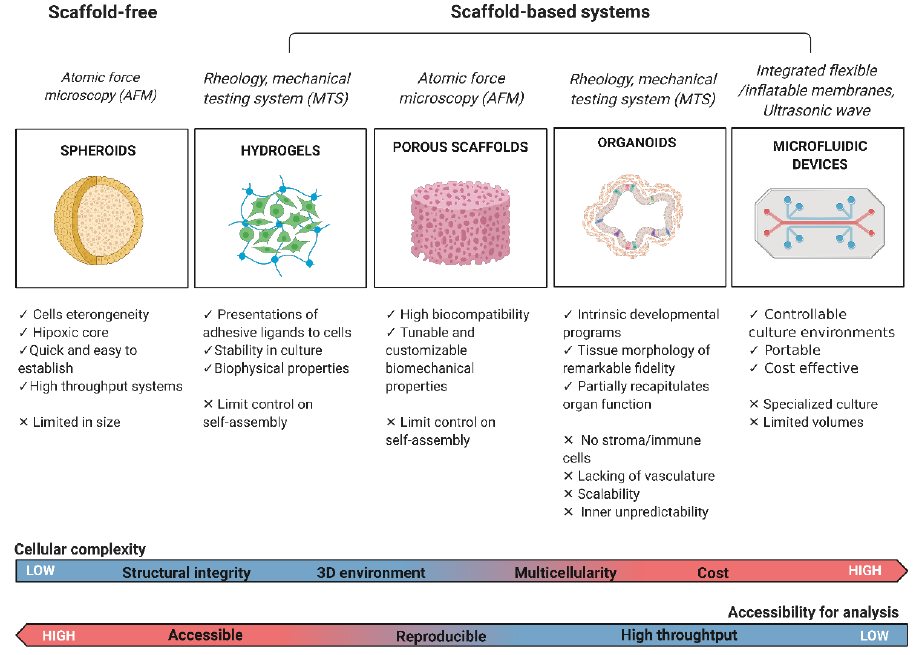
Figure 2. Classification of the most common cancer study models with their strengths and limitations. The primary mechanical tests performed on each platform are reported in italics. Biological and technical characteristics of the cancer model are highlighted. On the bottom, 3D in vitro systems cellular complexity and accessibility of imaging and analysis. Made with Biorender.